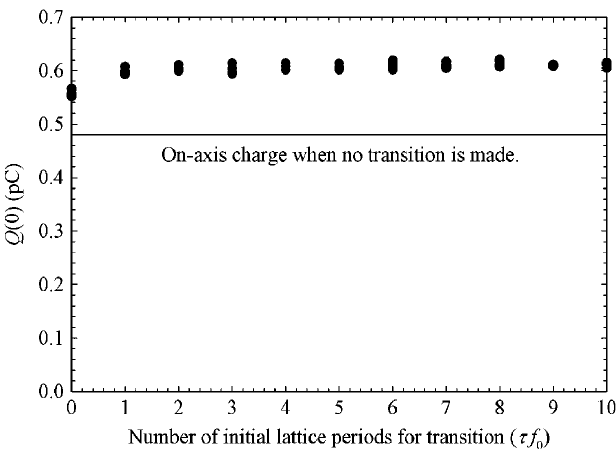
FIG. 4. The measured on-axis charge Q (cid:6) 0 (cid:7) , which is propor- tional to the peak plasma density, varies with the number of is made. Q (cid:6) 0 (cid:7) initial lattice periods over which the increase in ! q increases when the instantaneous frequency _ (cid:7) (cid:6) t (cid:7) = 2 (cid:1) is de- creased from 60 to 45 kHz. An instantaneous change compresses the beam less and increases the emittance as compared to an adiabatic change that is made over two or more lattice periods.